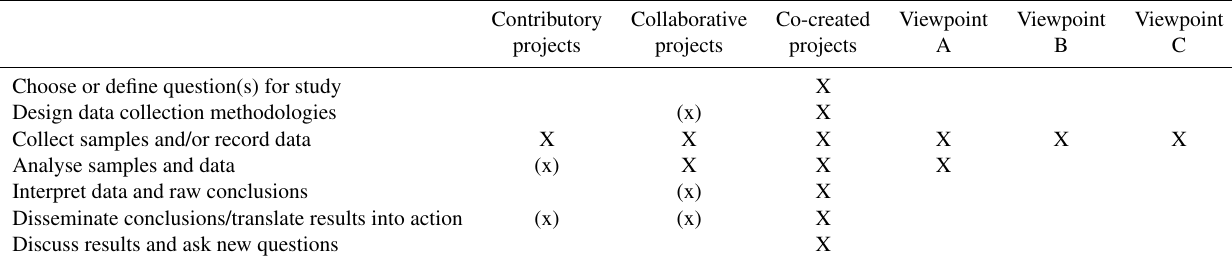
Table 5. Overview of theme IV (level of citizen participation), based on Bonney et al. (2009). Supported activities are marked with an X. An (x) indicates the activities are sometimes assigned to citizens. Contributory Collaborative Co-created Viewpoint Viewpoint Viewpoint projects projects projects A B C Choose or define question(s) for study X Design data collection